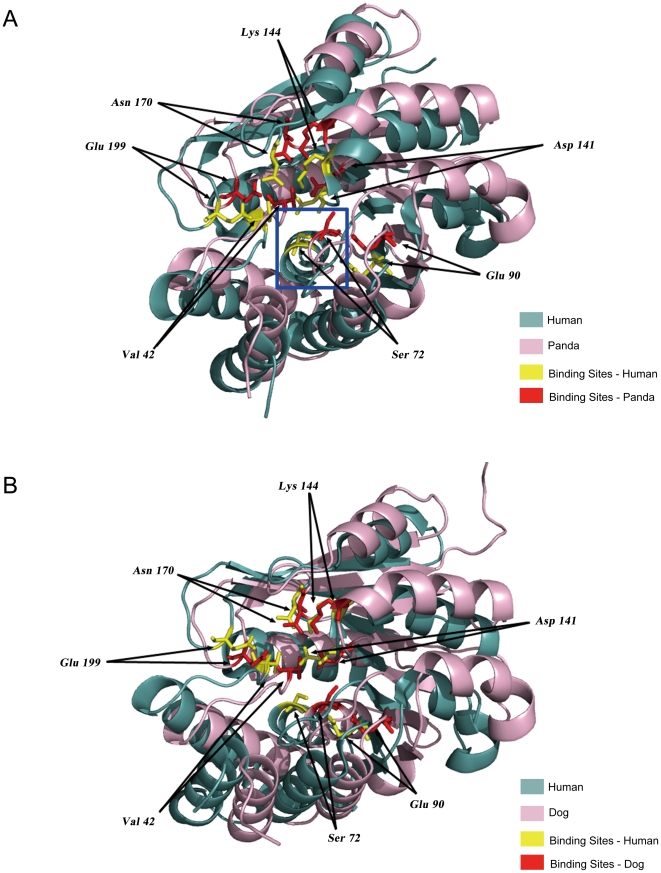
Panda and dog COMT protein structural simulation.The simulated panda or dog proteins were indicated with pink color for backbone and red color for special amino acid residues. Human proteins were indicated with blue color for backbone and yellow color for special amino acid residues. The side chain of COMT catecholamine substrate binding sites (Lys144, Asn170, Glu199) and SAM binding sites (Val42, Ser72, Glu90, Asp141) were shown in ball and stick model. (A) The simulated panda COMT structure compared with human COMT. The α4 helix in blue square has turned into a loop in panda. (B) The simulated dog COMT structure compared with human COMT.